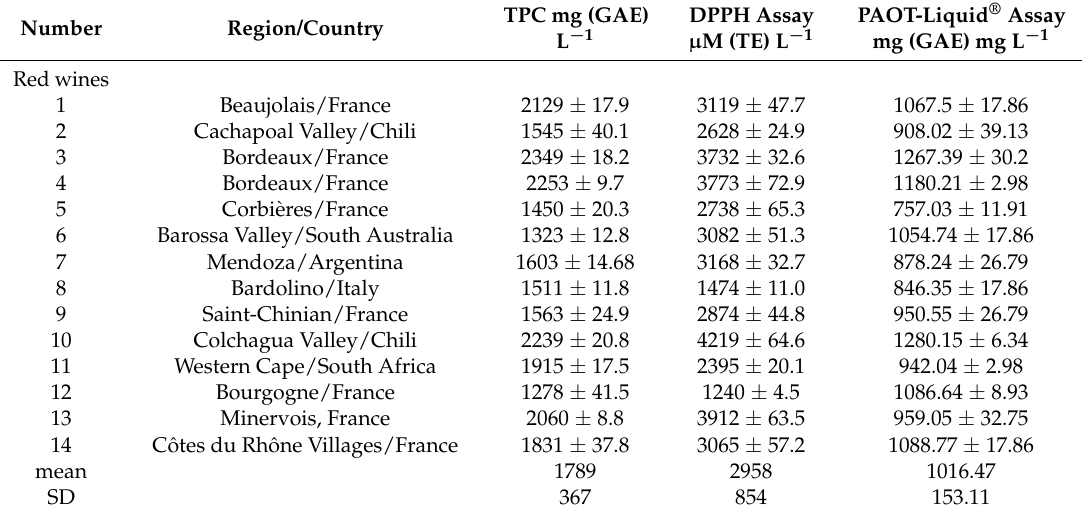
Table 3. Total polyphenol content (TPC) in tested wines and their antioxidant capacity as assessed by DPPH method and PAOT-Liquid ® Technology.